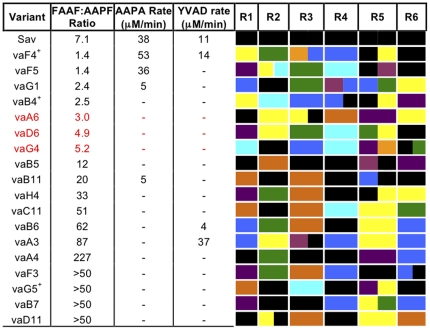
Characterisation of LibRall variants.Variants are blocked according to their FAAF:AAPF ratio class as described in the main text. The colour code for regions R1 to R6 are: black, Sav; blue, BPN; yellow, Alc; green, SbE; orange, AK1; purple, Ther; cyan, ISP. Sequence of hybrid regions described in Table S4. Variants with additional mutations are labelled with a +: G206S (vaF4), N221I (vaB4), T23L (vaG5).